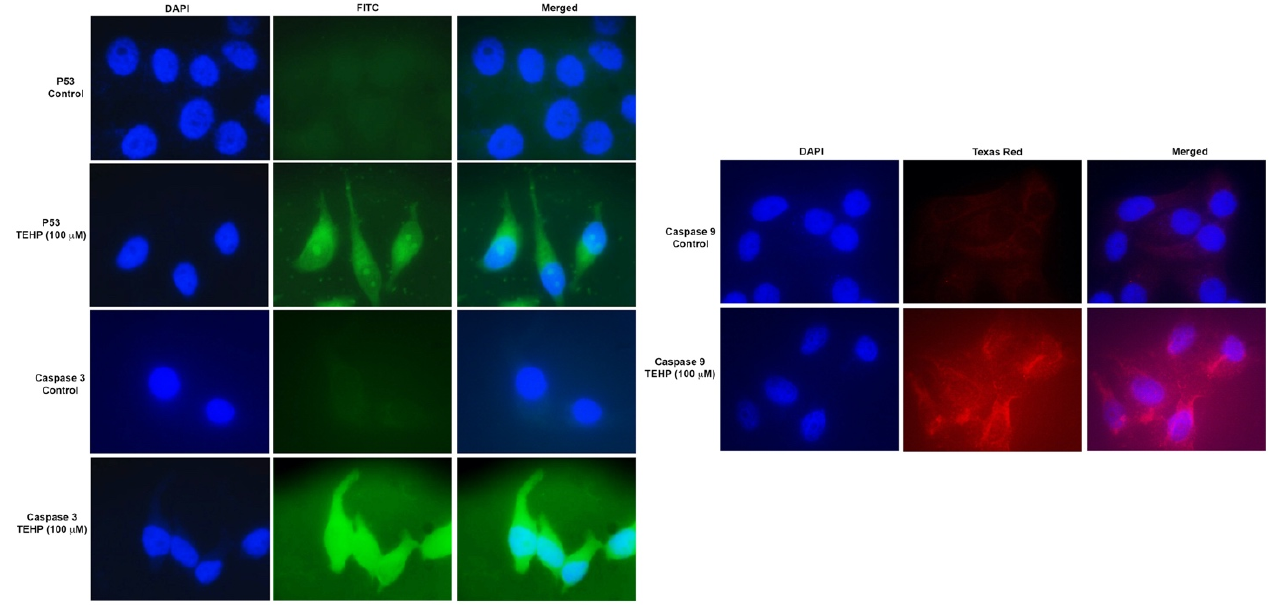
Figure 5. Translational activation of apoptotic proteins (P53 and caspases 3 and 9) in TEHP (100 µ M)-treated (72 h) HepG2 cells. Images were captured at 100 × magnification by the use of a fluores- cence microscope.